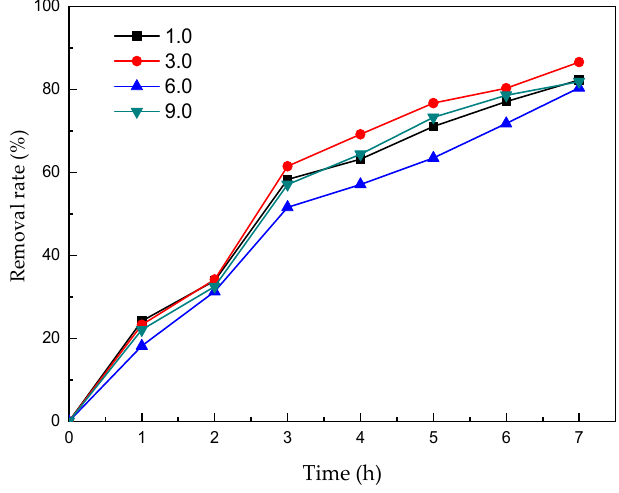
Figure 8. Effect of pH on the degradation of nicosulfuron.